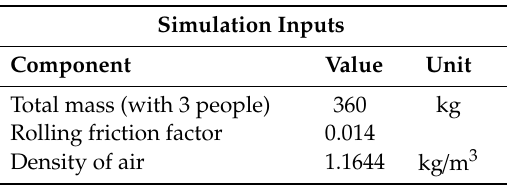
Table 2. Simulation situation